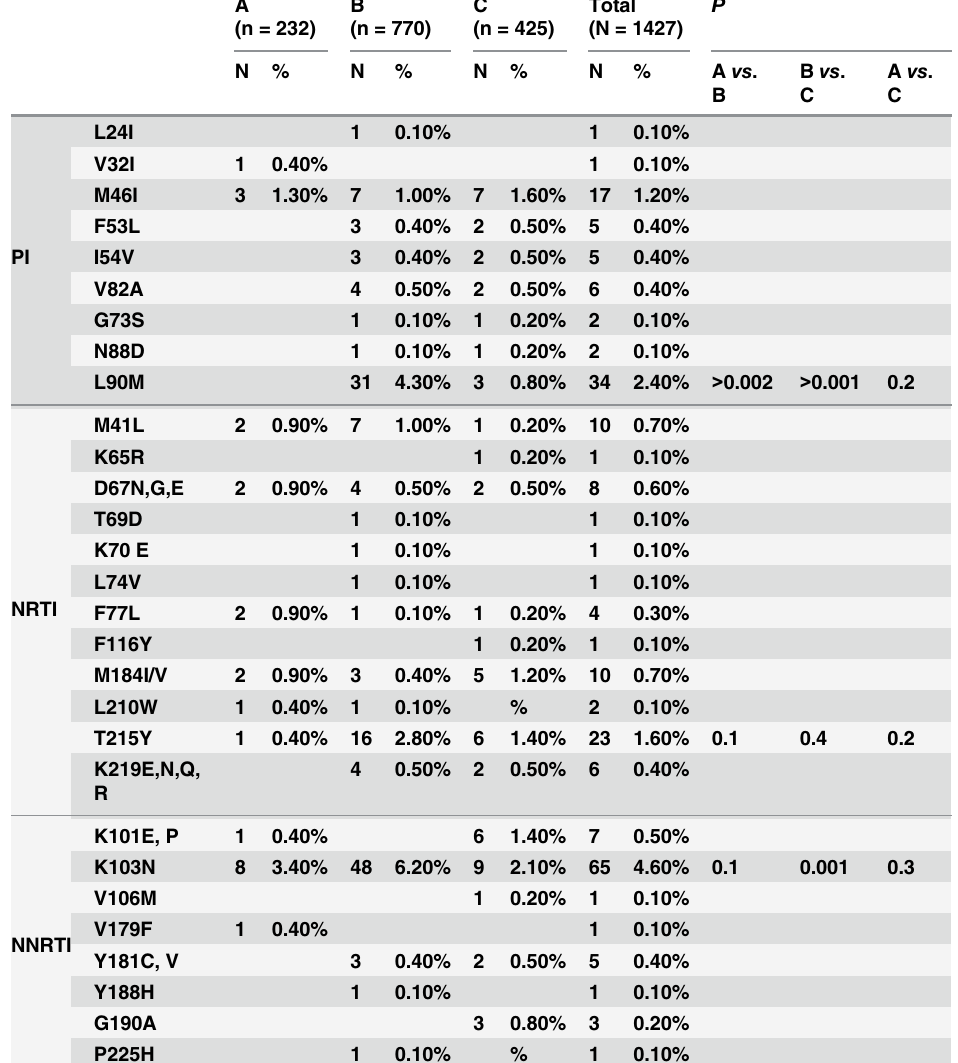
Table 2. Transmitted drug resistance (TDR).